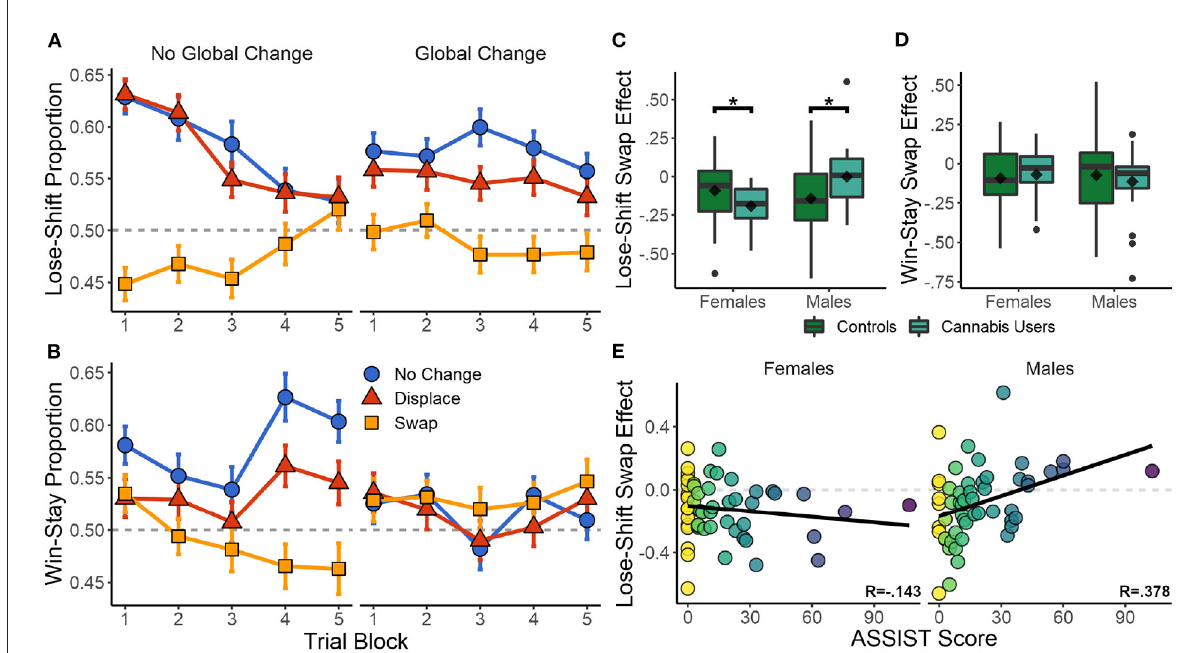
FIGURE3 Effects of target reconfiguration and recreational drug use on reinforcement-driven behavior. (A,B) Effect of local and global changes in choice position on lose-shift and win-stay tendencies for all participants. SEM in error bars. (C,D) Box plots of the difference in lose-shift and win stay when target positions are swapped as compared to no change. The effect of swapping targets on lose-shift is higher in women who use cannabis, but lower in men who use cannabis, than their sex-matched controls. (E) Correlation between total drug use (ASSIST) and swap effect on lose-shift. * p <